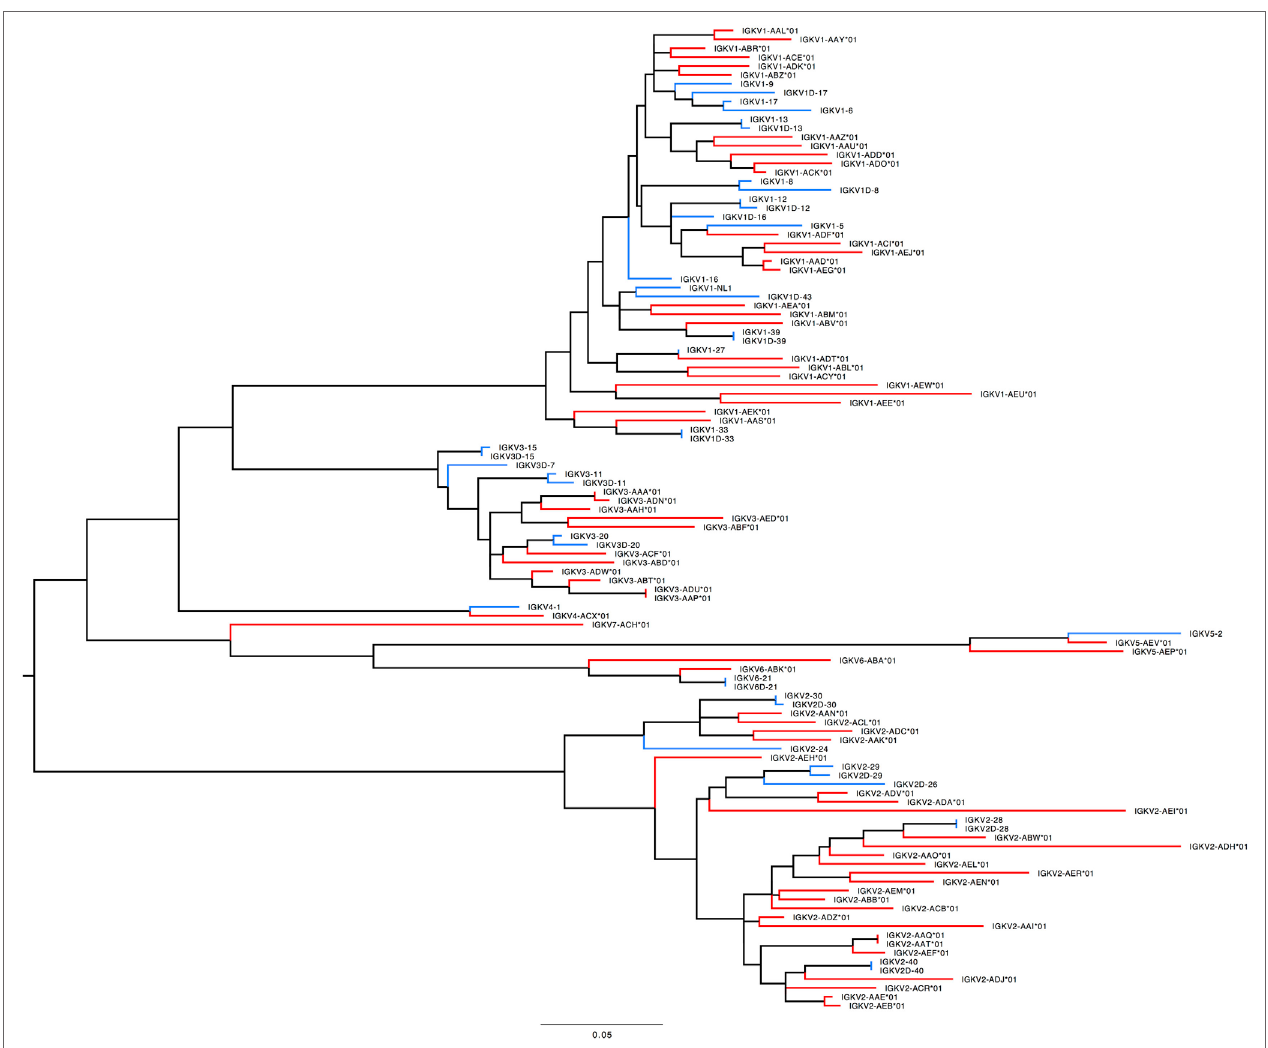
FigUre 8 | Maximum likelihood phylogenetic tree of the human and rhesus IGKV functional genes. Human immunoglobulin (Ig) V genes are represented in blue and macaque Ig V genes in